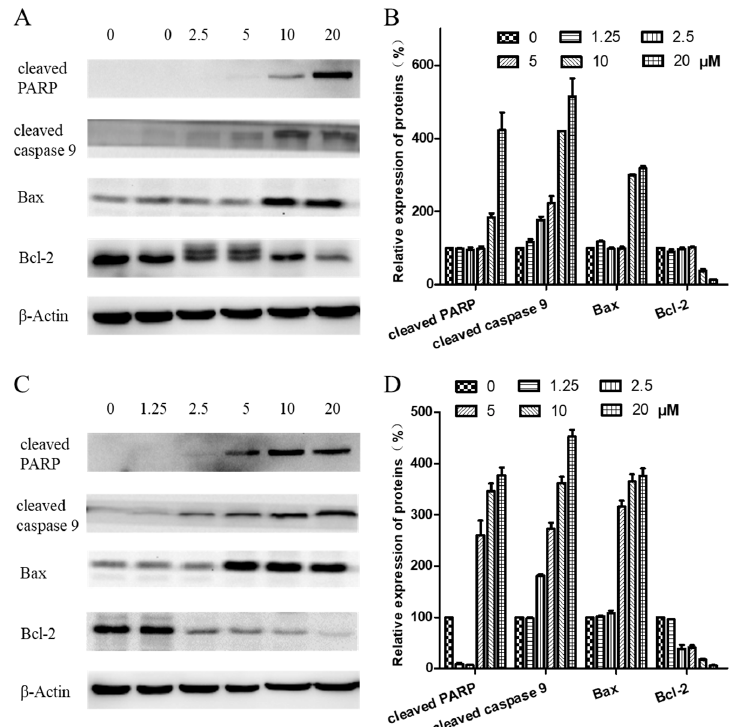
Figure 7. Effects of arnicolide D on the expression of apoptotic proteins. CNE-2 cells were treated with arnicolide D at concentrations of 1.25–20 µ M for 24 h or 48 h, and cell lysates were harvested and subjected to a Western blot analysis using antibodies against cleaved PARP, cleaved caspase 9, Bax, and Bcl-2. β -actin was used as an internal control. Western blot results are shown for ( A ) 24 h or ( C ) 48 h treatments. Bar graphs ( B and D ) showing the quantified relative expression of the proteins. Data are expressed as means ± SD.